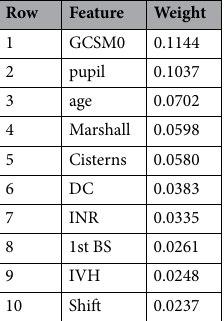
Table 5. Feature weights calculated by information gain applied on 5-classes-dataset of fGOS. GCSM0: motor component of GCS on admission, DC: decompressive craniotomy, INR: international normalized ratio, BS: blood sugar, IVH: intraventricular